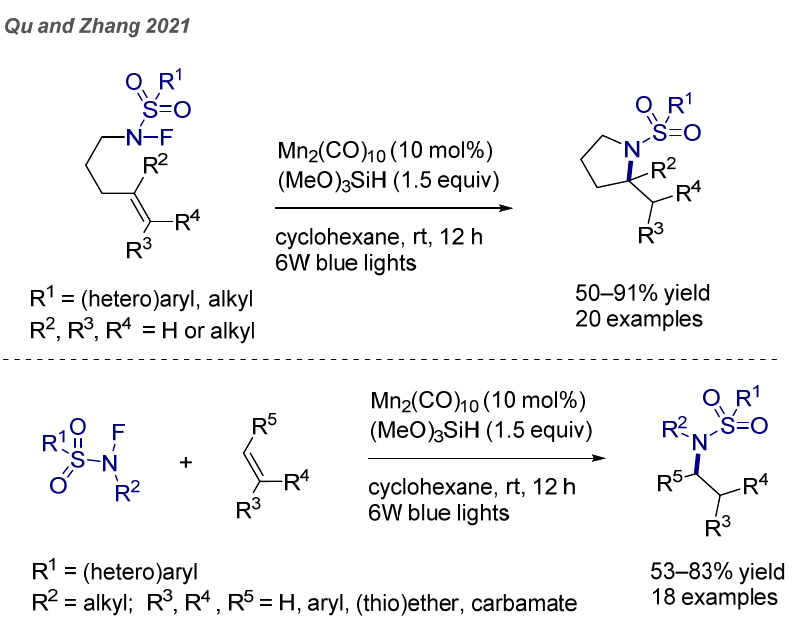
Figure 1. Visible-light induced manganese-catalyzed alkene hydroamination with N -fluorinated sulfonamides. rt = room temperature.